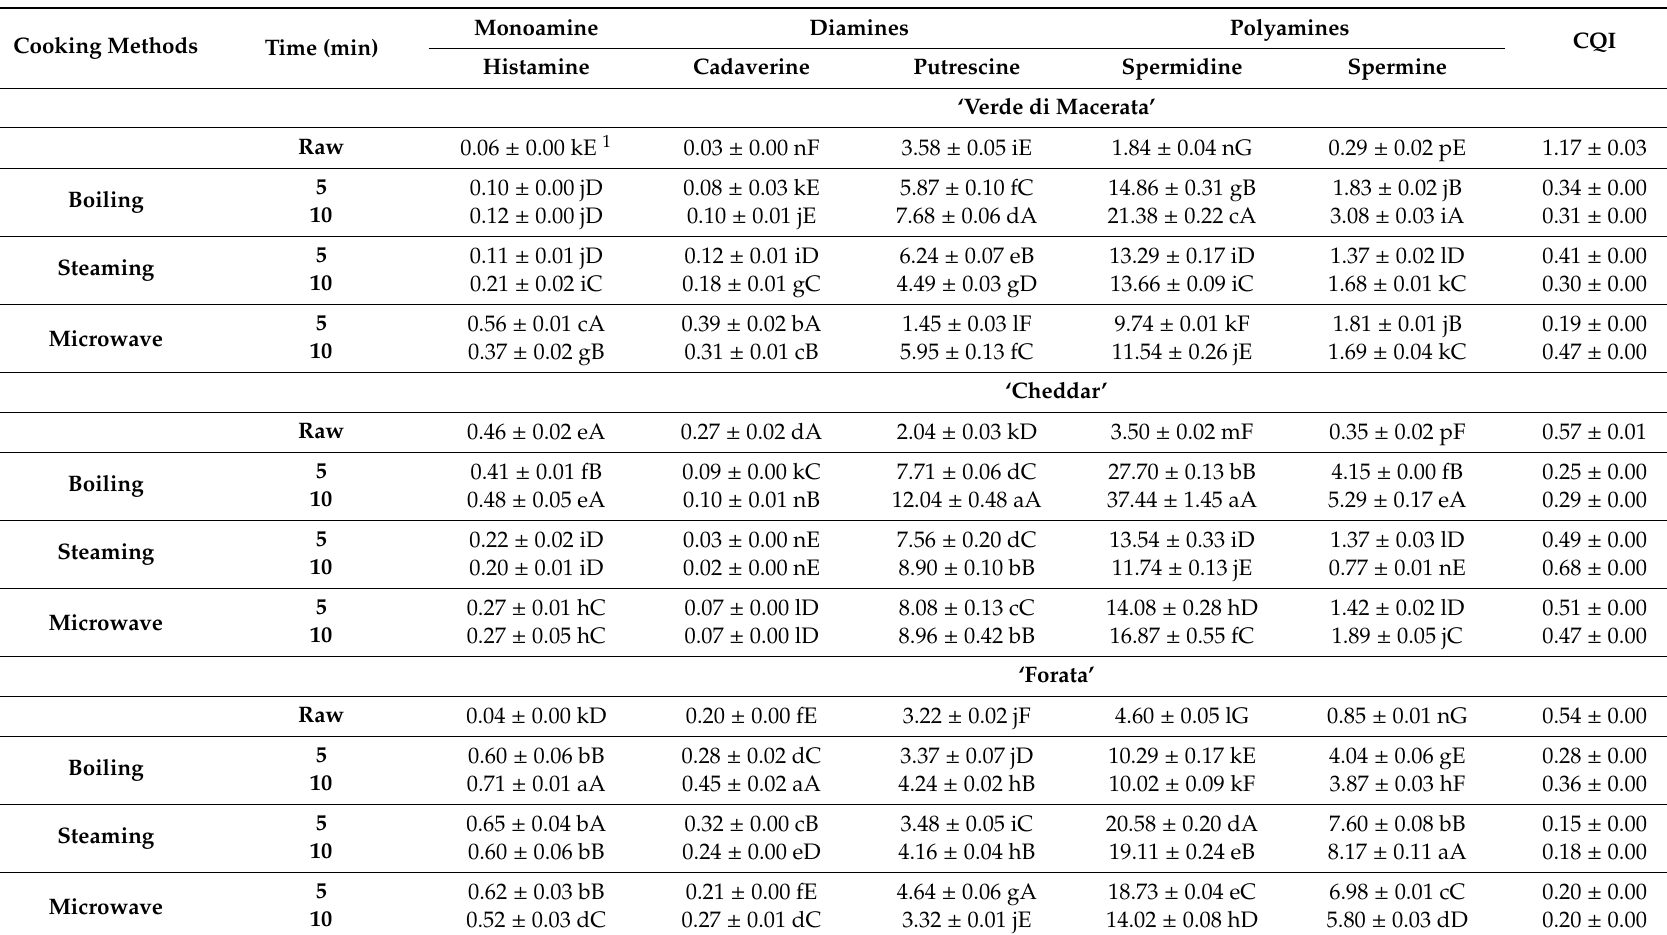
Table 2. Monoamine, diamines, polyamines (ug / g d.w.) and CQI in colored cauliflowers raw and thermally